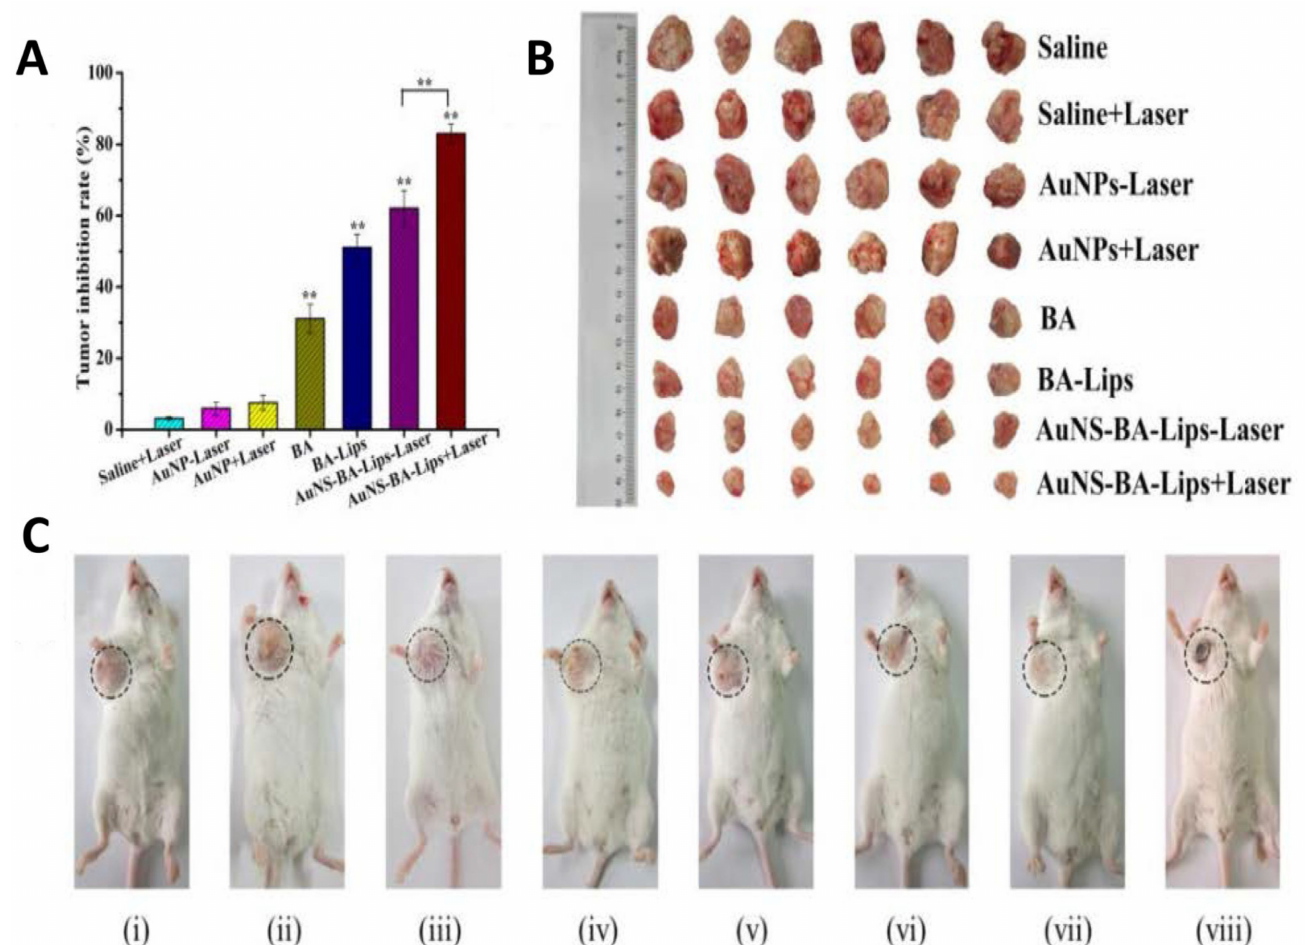
Figure 4. ( A ) The tumor inhibition rates. ( B ) Photographs of tumors after 14 days of treatment. ( C ) Representative photographs of tumor-bearing mice after 14 days of treatment. (i) saline, (ii) saline + Laser, (iii) AuNP-Laser, (iv) AuNP + Laser, (v) BA, (vi) BA-Lips, (vii) AuNS-BALips-Laser, (viii) AuNS-BA-Lips + Laser. The tumor was marked with dashed circles. ** p < 0.01. Reproduced from ref. [233] with permission from Elsevier. Copyright (2017)